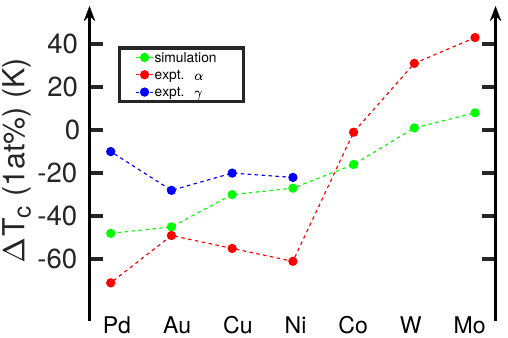
Figure 4. Change in the α - γ transition temperature, ∆ T c , induced by various alloying atoms X at 1 at% concentration in Fe. Simulation results are compared to experimental data from [6,40]. Here, α and γ denote the boundaries of the α and the γ field to the coexistence field, α + γ , cf. Figure 1a. If no γ data are shown (Co, W, Mo), the coexistence field is negligible or non-existent.